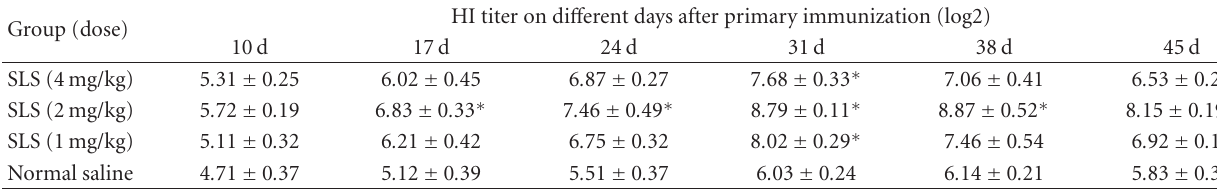
Table 2: The antibody response in SLS-treated and vaccinated chickens.